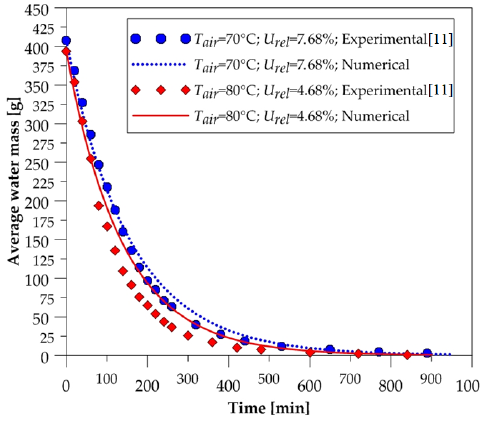
Figure 5. Average water mass of the brick as a function of the drying time (70 and 80 °C).